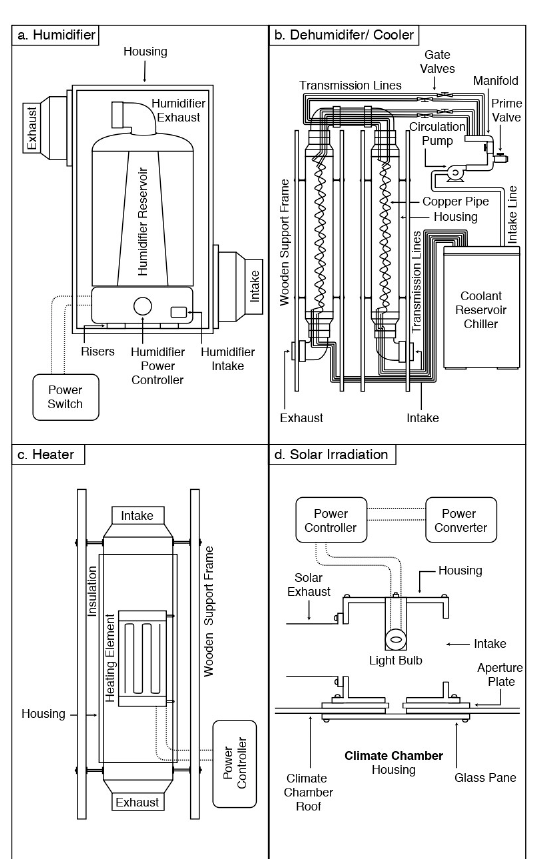
Figure 3. Schematic of the supporting modules: ( a ) humidifier, ( b ) dehumidifier/cooler, ( c ) heater, and ( d ) solar irradiation.